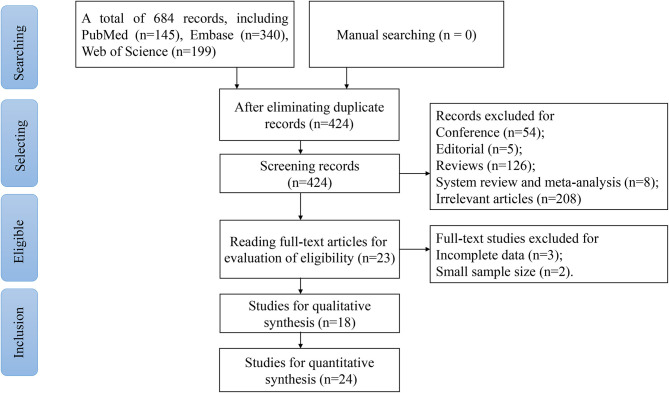
The flow chart of the study screening.